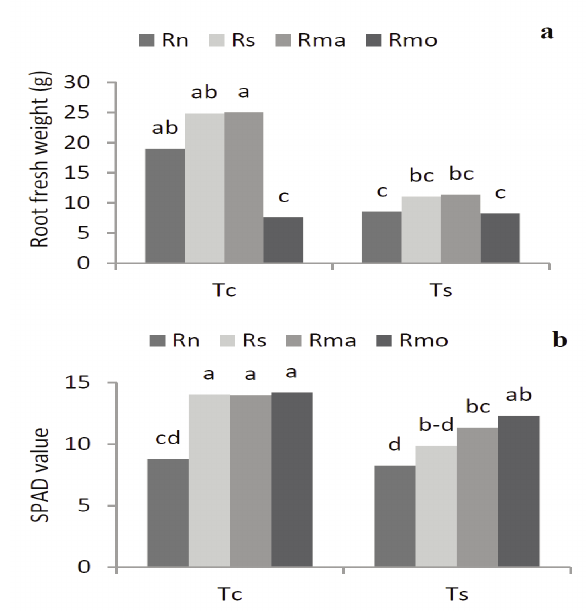
Fig. 2 ­ The interaction effect of temperature and cucumber grafting on root fresh weight (a) and SPAD value (b) Tc= optimum temperature; Ts= low temperature; Rn = non­ grafted ( Cucumis sativus var. Davos II); Rs= self grafted; Rma= Cucurbita maxima ; Rmo= Momordica charantia